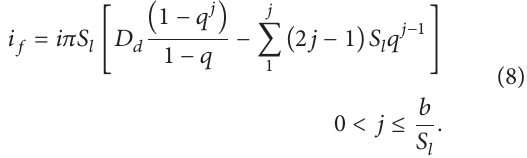
Figure 5: Diagram of flat grinding with abrasive circle